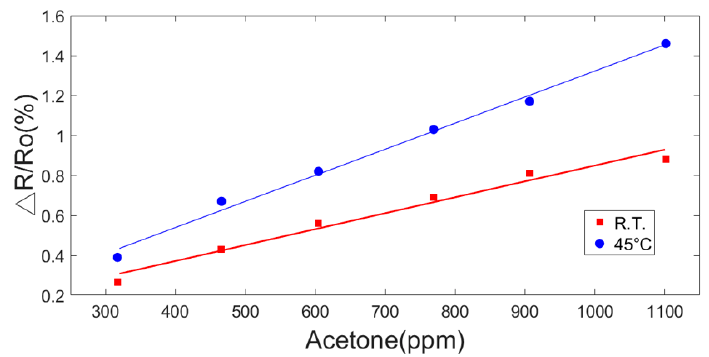
Figure 14. The fitting curves of the sensor response at different operating temperature as a function of acetone concentration (300–1000 ppm).